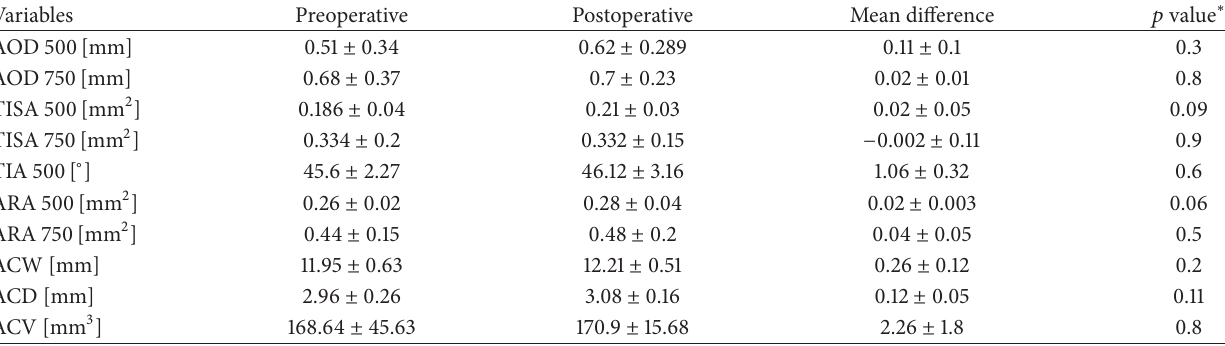
Table 1: Comparison of the angle measurements with swept source OCT before and after Trabectome-only surgery. Variables